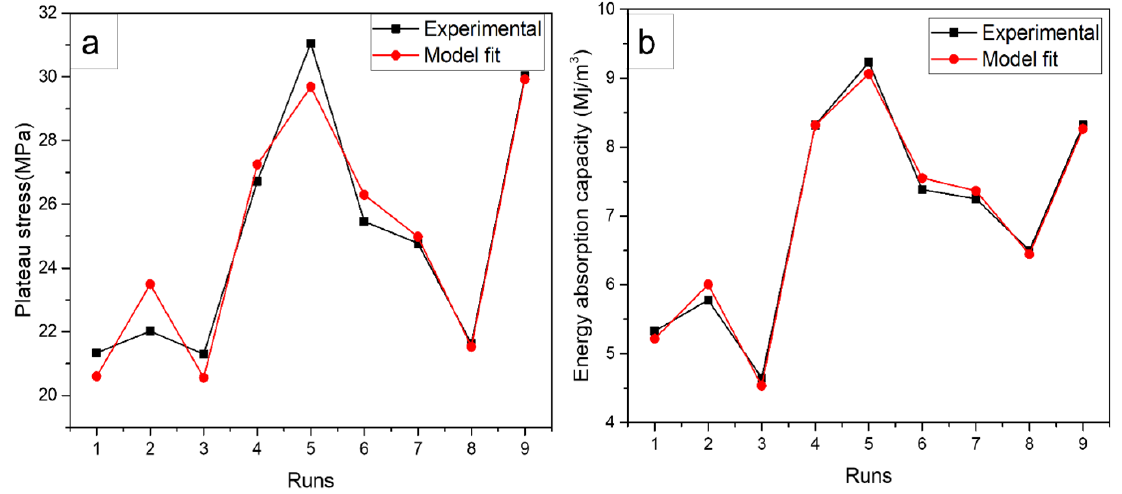
Figure 11. Comparison of experimental and modal predicted values for, ( a ) plateau stress and ( b ) energy absorption capacity.